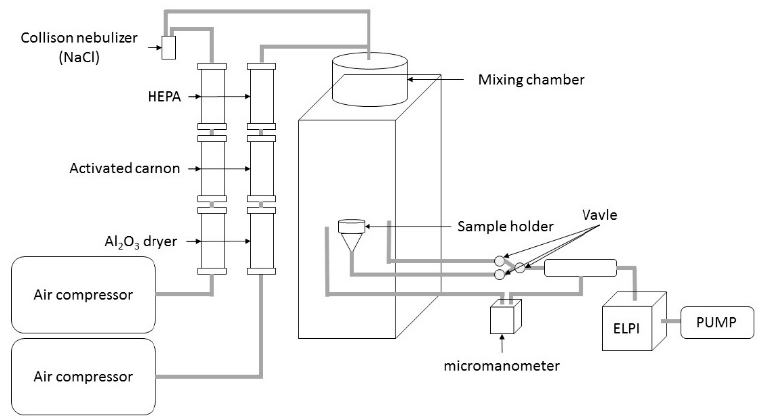
Figure 2. Diagram of the filtration efficiency (FE) and pressure drop tests.